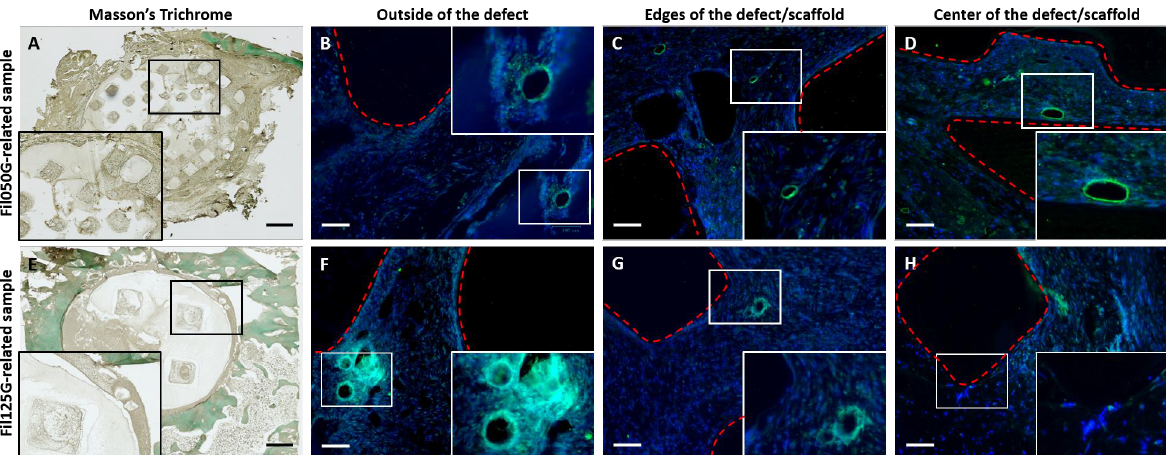
Figure 7. Histological staining with Masson’s Trichrome ( A , E ) and Laminin immunostaining ( B – D , F – H ) on Fil050G- and Fil125G-related samples after 10 days of implantation; ( A ) Histological staining of Fil050G-related samples with Masson’s Trichrome. ( B , F ) Laminin immunostaining outside of the defect/scaffold. ( C , G ) Laminin immunostaining at the edges of the defect/scaffold. ( C , H ) Laminin immunostaining at the center of the defect/scaffold. ( E ) Histological staining of Fil125G-related samples with Masson’s Trichrome. Laminin staining is shown as green (Alexa488) and DAPI in blue. Red dashed lines are delimiting the scaffold. Scale bar for ( A , E ) = 1 mm. Scale bar for ( B – D , F – H ) = 100 µm.